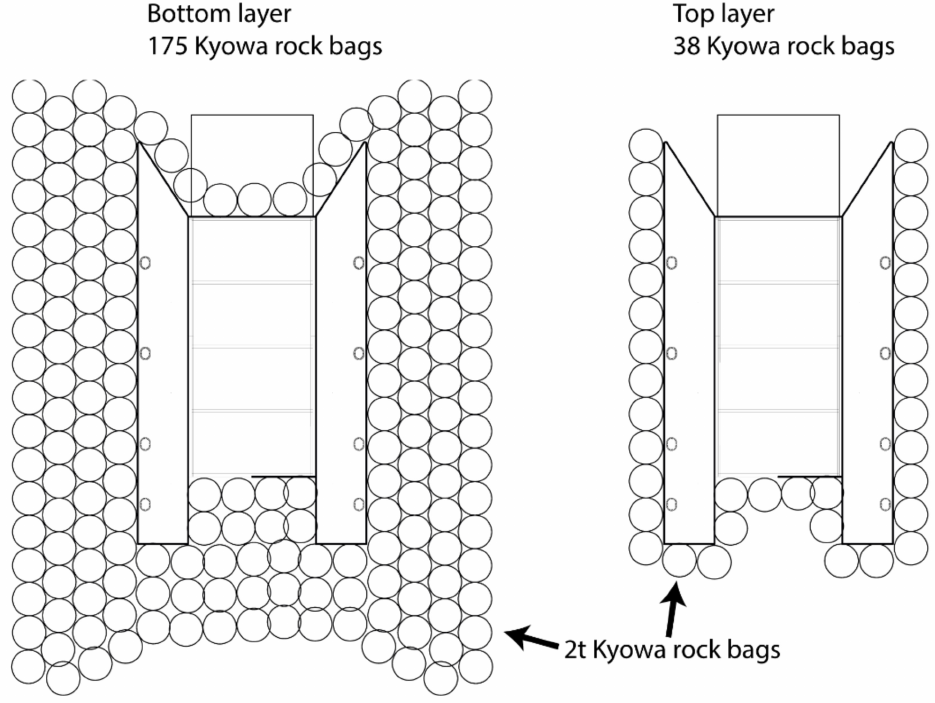
Figure 3. Schematic of scour protection placed around the OWC WEC at Location 2 on 6 April